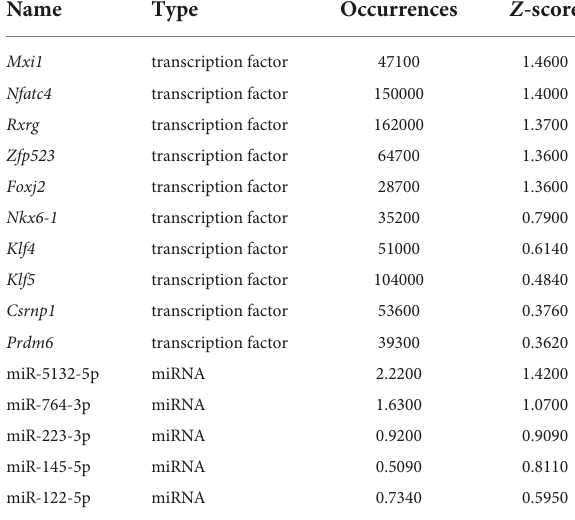
FIGURE6 M-T-G and PPI networks. (A) Establishment of the M-T-G network of 13 DEMs, 49 DETFs, and 460 DEGs. The genes, miRNAs, and TFs are represented by yellow circles, red rectangles, and blue triangles, respectively. The key nodes are highlighted with larger sizes. (B) Establishment of the PPI network based on the 460 joint targets of DEMs and DETFs.